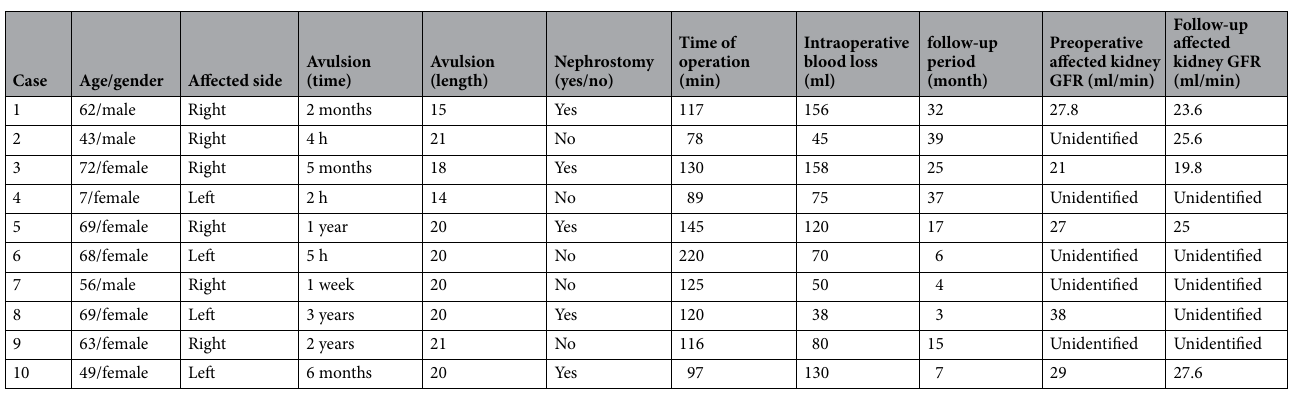
Table 1. Baseline features of included